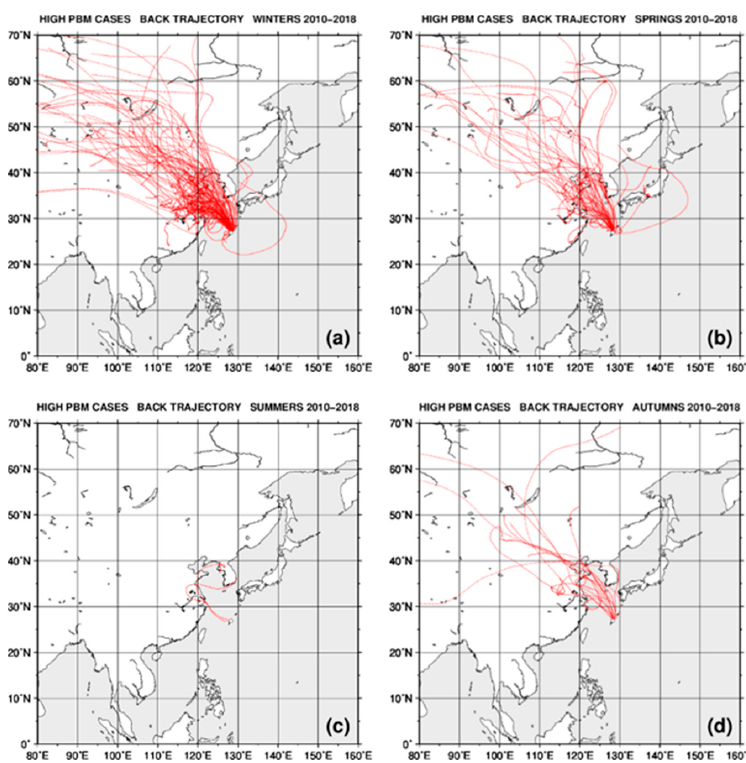
Figure 6. Seasonal changes in the pathway of the air mass arriving at Cape Hedo when GOM pollution events were observed in ( a ) winter, ( b ) spring, ( c ) summer, and ( d ) fall.